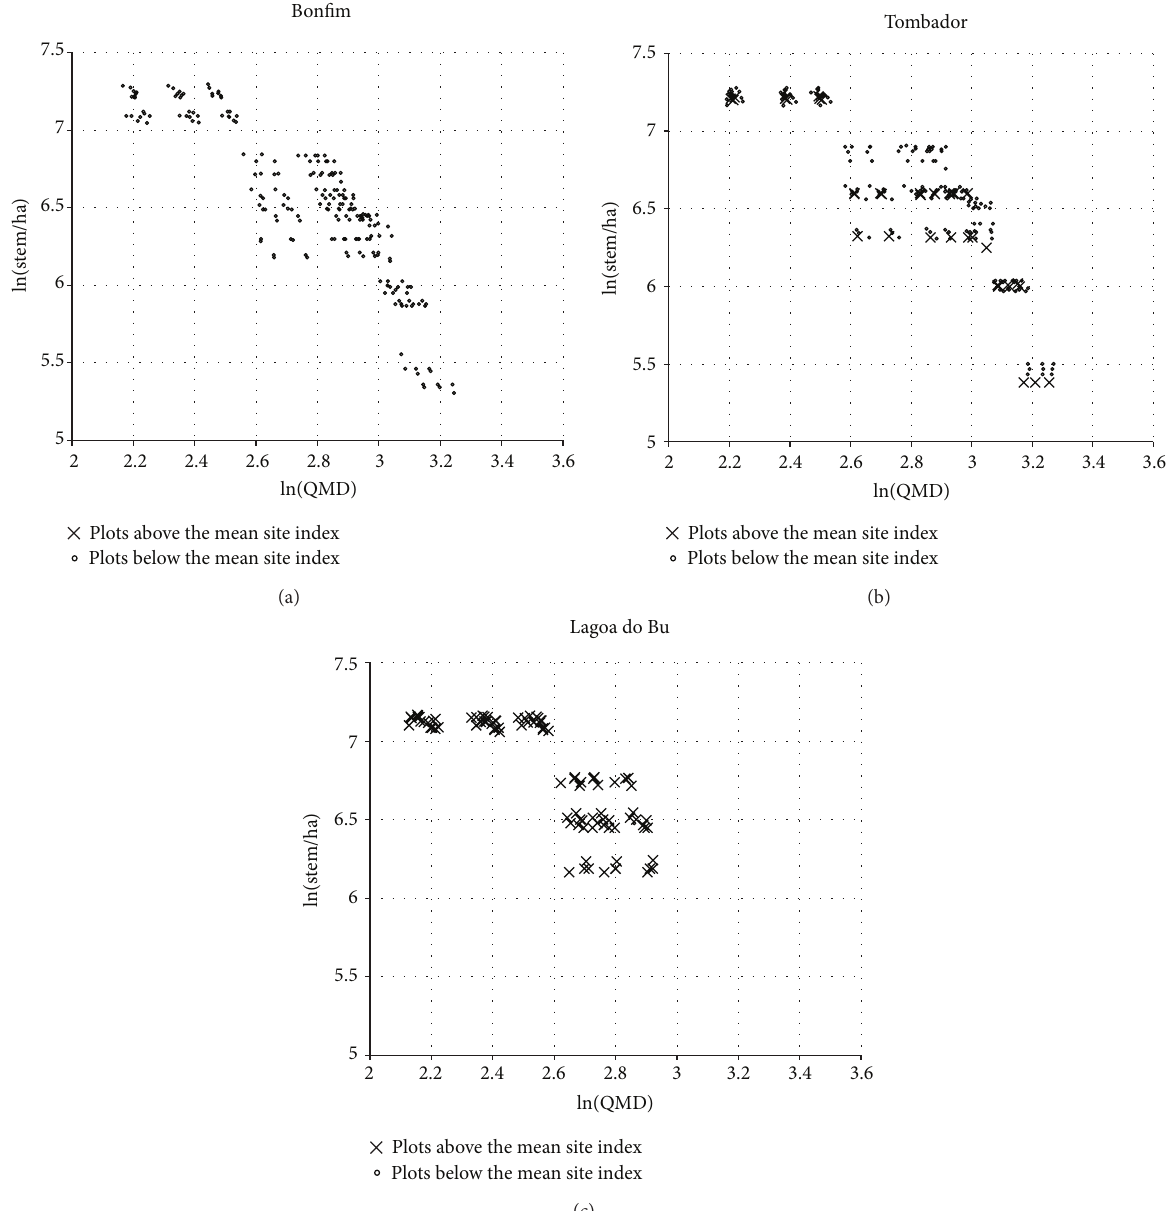
Figure 4: Mean tree size (lnQMD) and stand density (In(stemsha −1 )) at the Bonfim, Tombador, and Lagoa do Bu